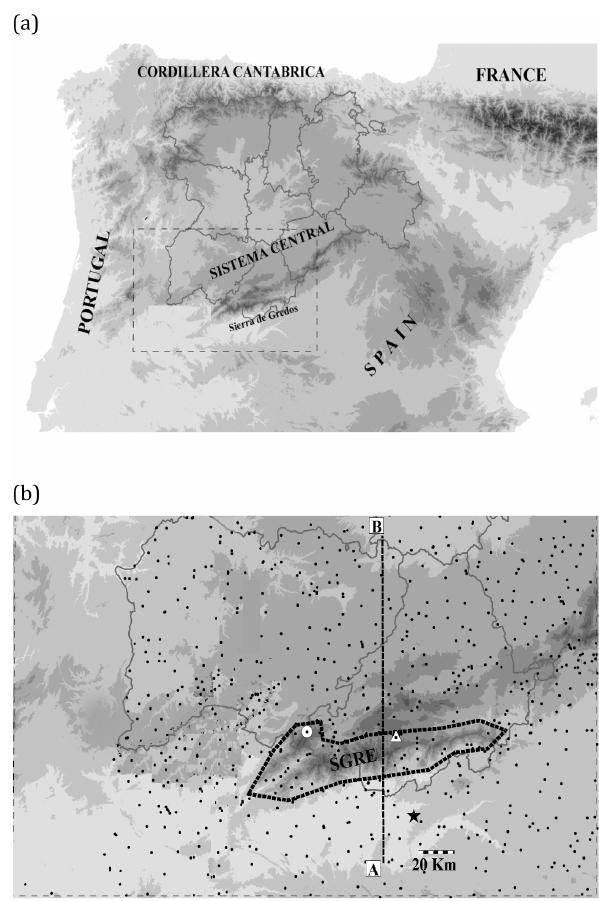
Figure 1. (a) Main orographic features in the northwestern Iberian Peninsula. Polygons represent the provinces of the region of Castilla–León. The dashed line corresponds to the area studied. (b) Study area: the polygon indicates the Gredos Range (SGRED); vertical line AB is the reference line for the orographic and precip- itation profile shown in Fig. 2; black dots indicate the weather sta- tions where precipitation was measured; the circle and triangle mark the automatic weather stations at La Covatilla and Navarredonda re- spectively; the star is the reference point for calculating the param- eters used in the study (40 ◦ 16 (cid:48) 31 (cid:48)(cid:48) N, 5 ◦ 09 (cid:48) 32 (cid:48)(cid:48)